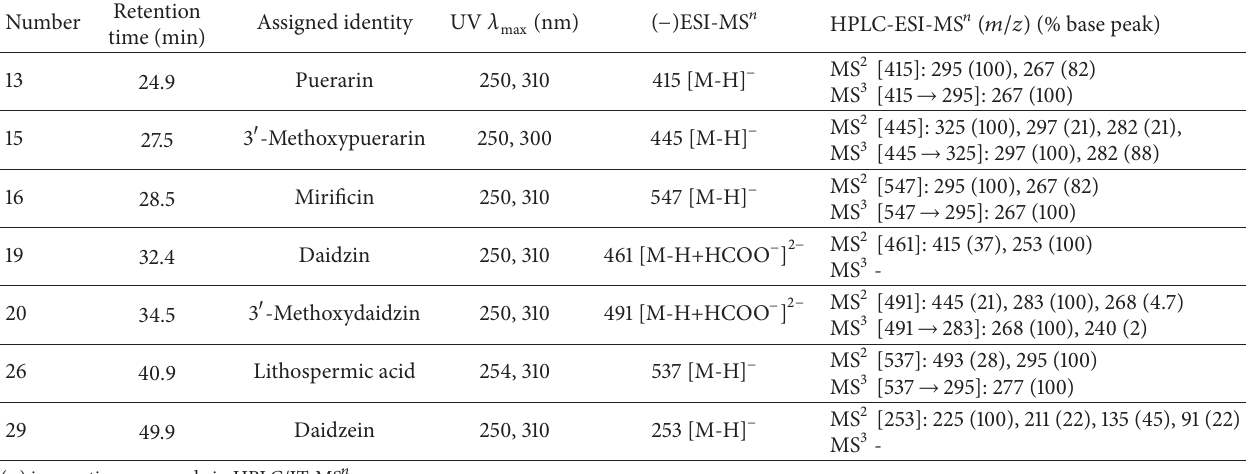
Table 3: Identification of common peaks by HPLC/IT-MS 𝑛 .